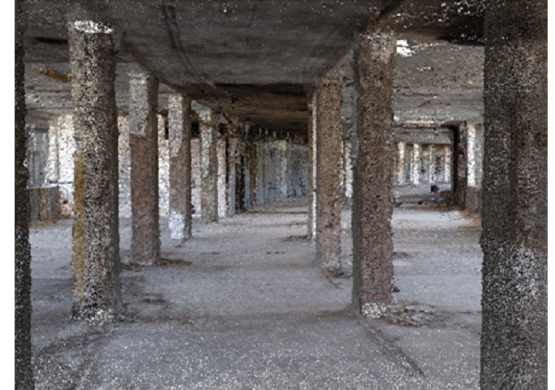
Figure 4: Internal view of a point cloud of a standard level.